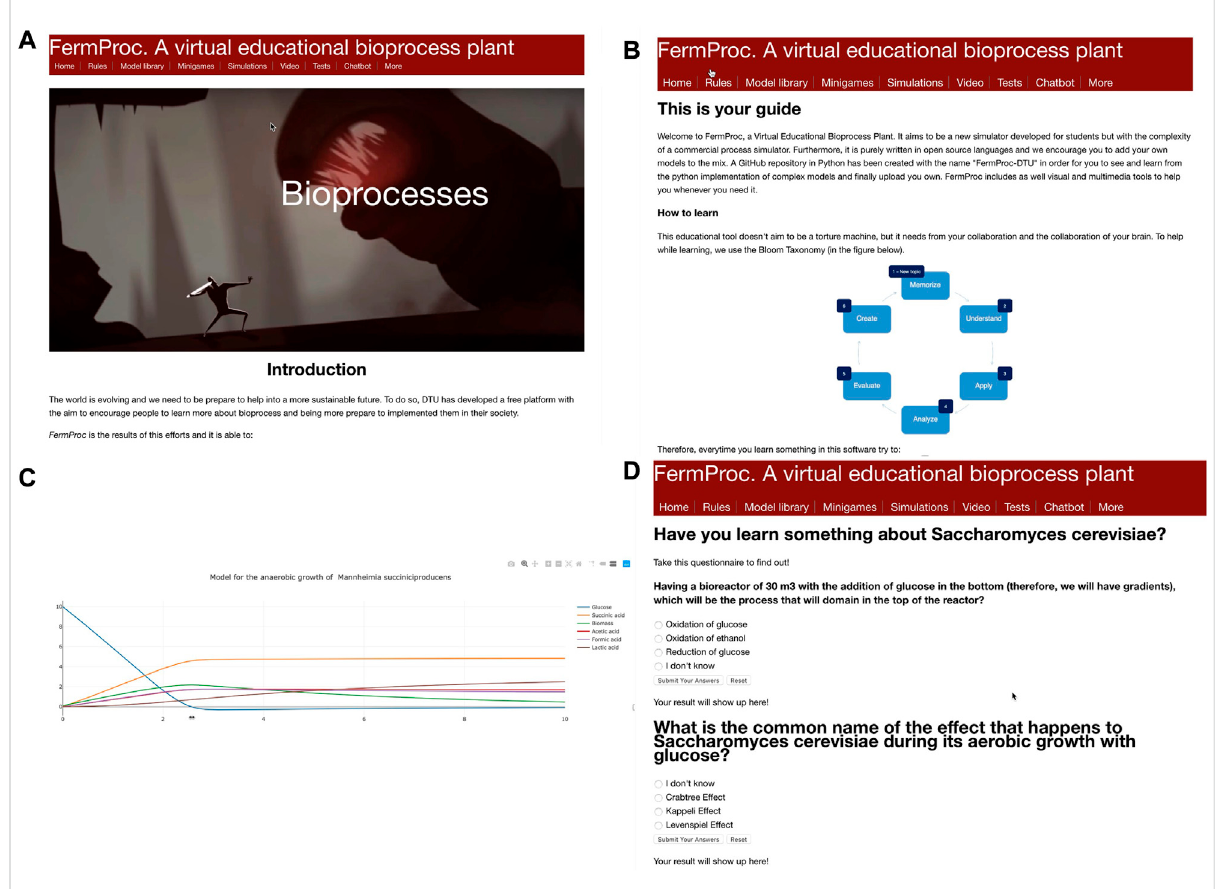
FIGURE 4 Inline software prototype version. (A – D) demonstrate the different software